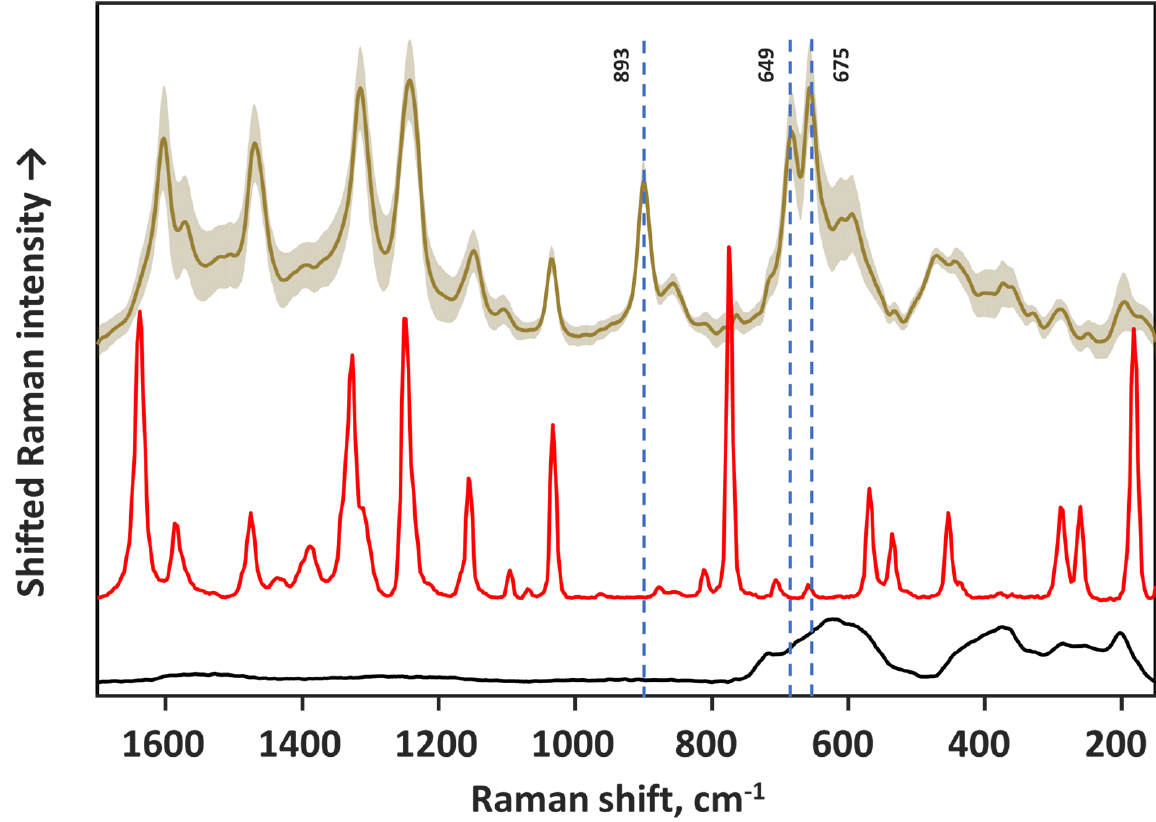
Figure 5. Raman spectra of MXene film (bottom) and salicylic acid: dried on MXene surface (middle) and on aluminum foil (top). Excitation wavelength—633 nm.